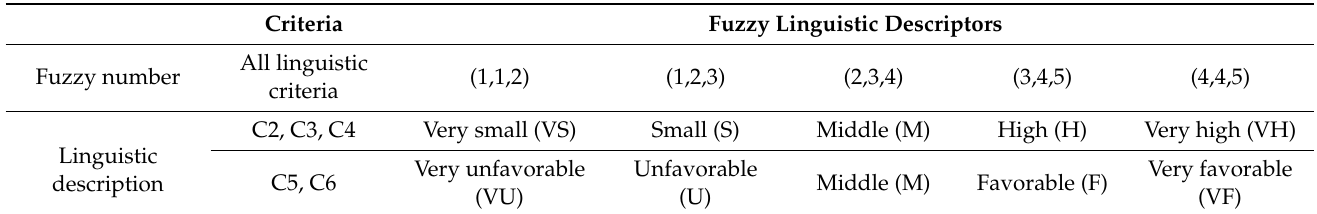
Table 1. Description of fuzzy linguistic descriptors.